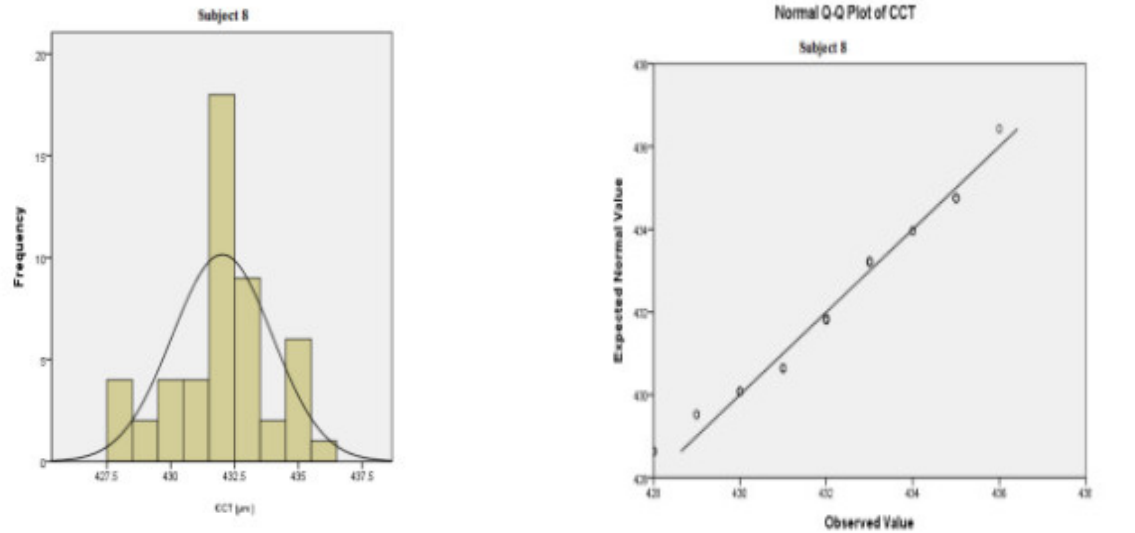
Figure 6: Histogram and normal probability plot for the CCT of subject 8. The samples were not normally distributed according to the p -values for the K-S, Lilliefors and S-W tests. The p -values for all the three tests were < 0.05, suggesting rejection of the null hypothesis that the sample is from a normally distributed